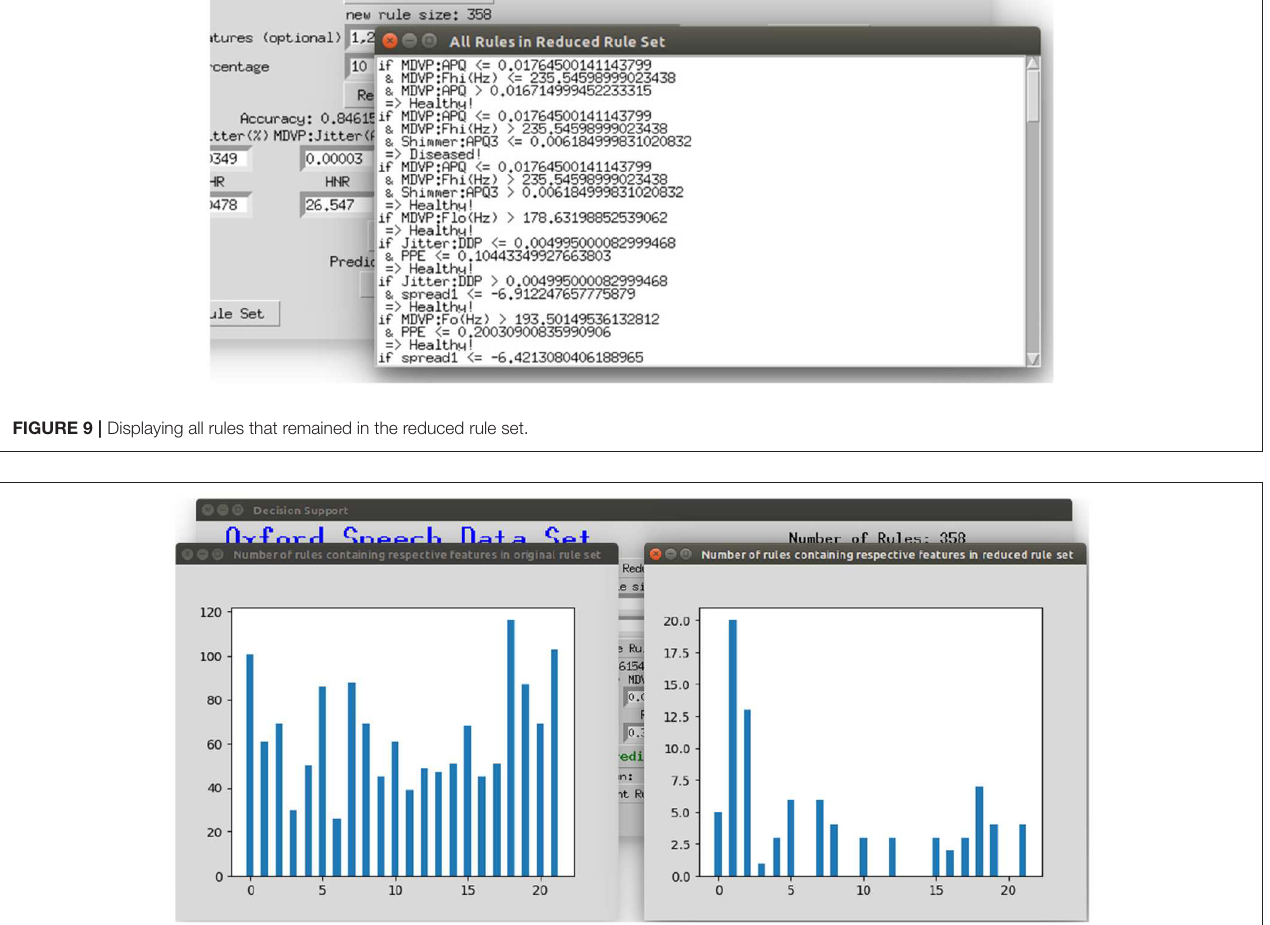
FIGURE 10 | Displaying the number of rules containing the respective feature in the original rule set and the current reduced rule set.